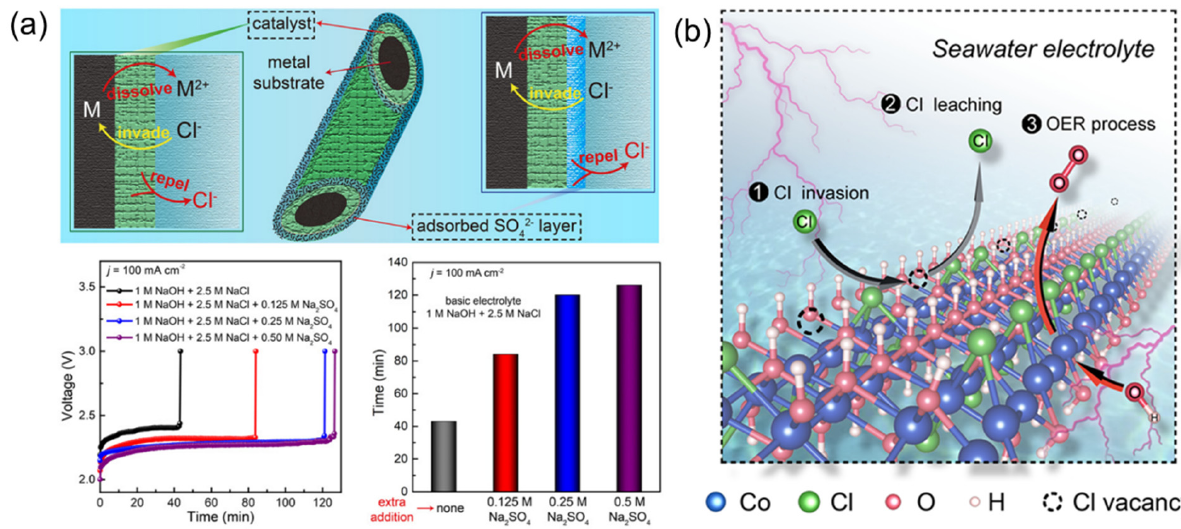
Figure 12. ( a ) Catalysts and electrolyte optimization to protect the metal substrate from Cl − corrosion to improve the OER stability in seawater [59]; ( b ) Mechanism of the lattice Cl − to protect the catalyst from Cl − corrosion and deactivation [17].